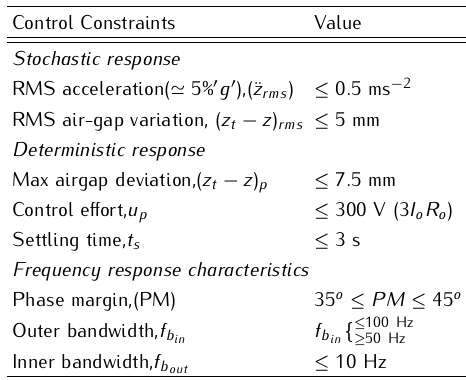
Table 2. Closed-loop Control Constraints Required for the Suspen-